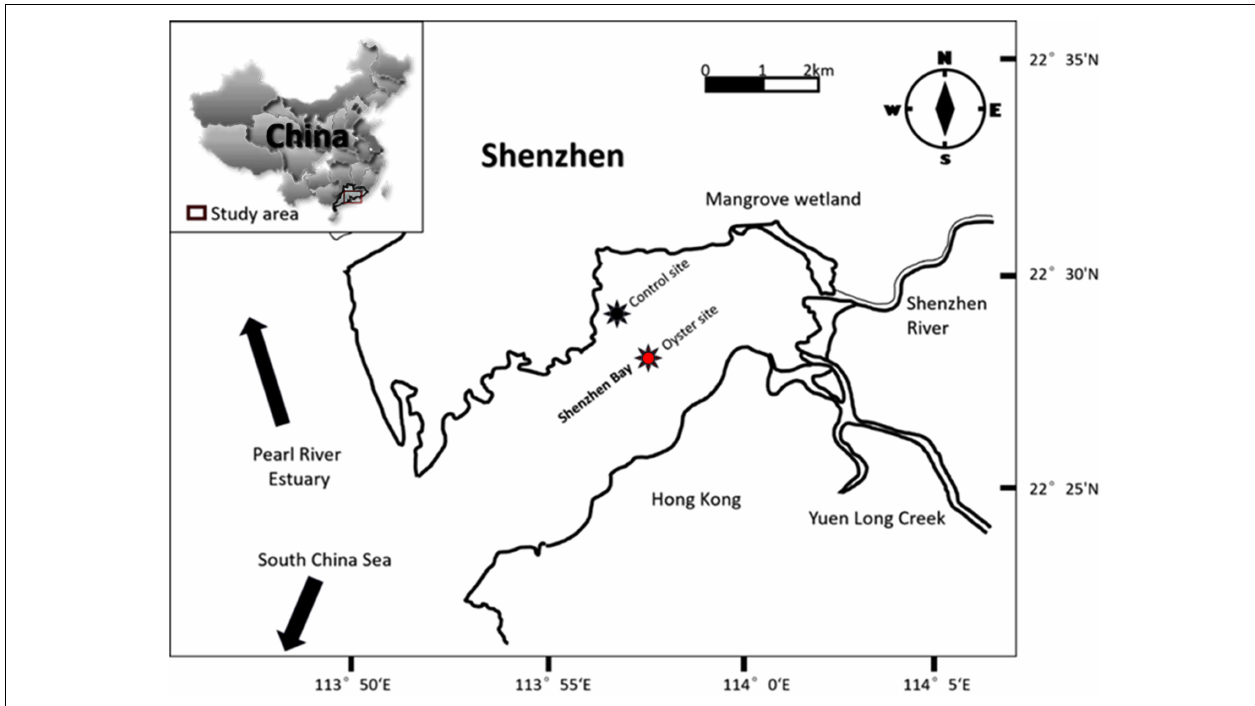
FIGURE 1 | Map of Shenzhen Bay. The red star shows the oyster farming area (site under oyster biodeposition (OBD) influence), and the dark purple star indicates the control site (area without any shellfish culture).